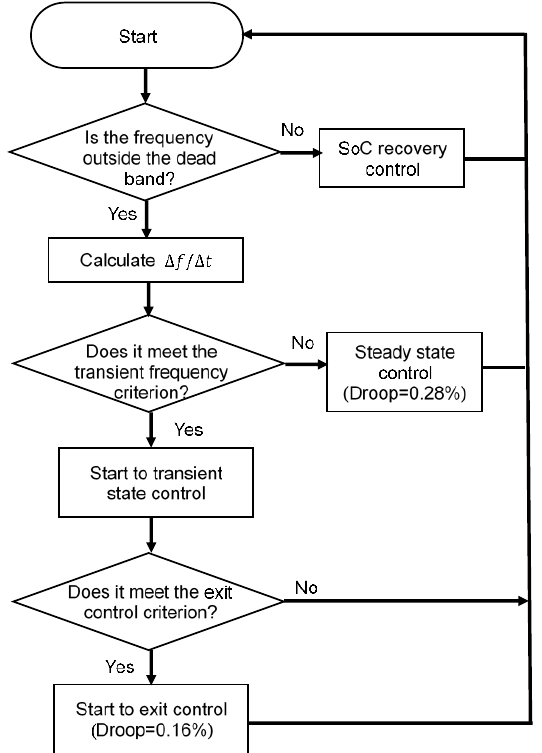
Figure 2. BESS ’ s frequency regulation control algorithm [24]. Figure 2. BESS’s frequency regulation control algorithm